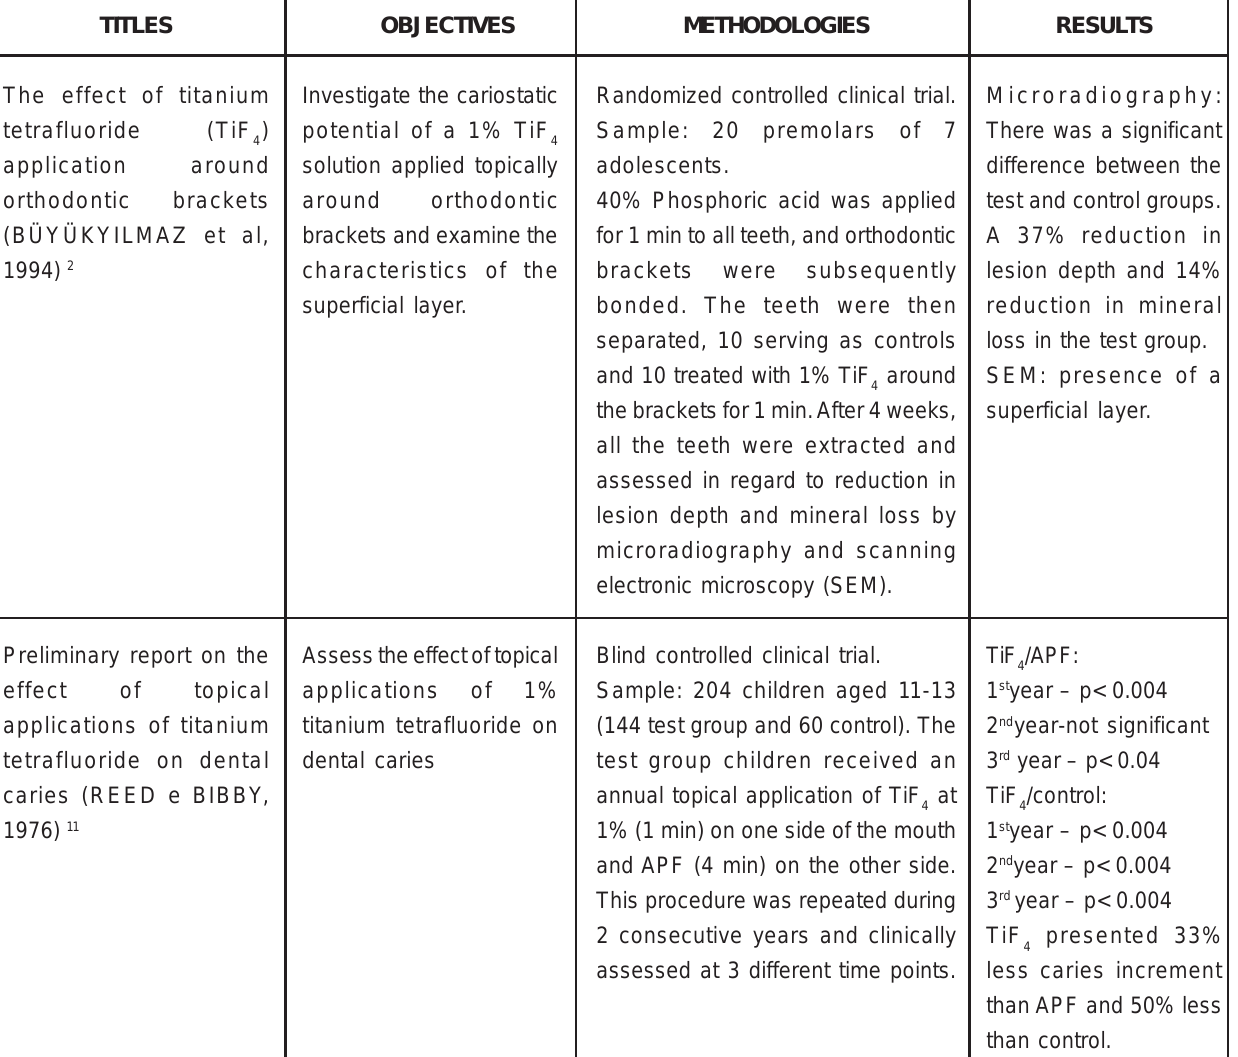
FIGURE 1- Studies analyzed and their objectives, methodologies and results. Natal, RN, Brazil,